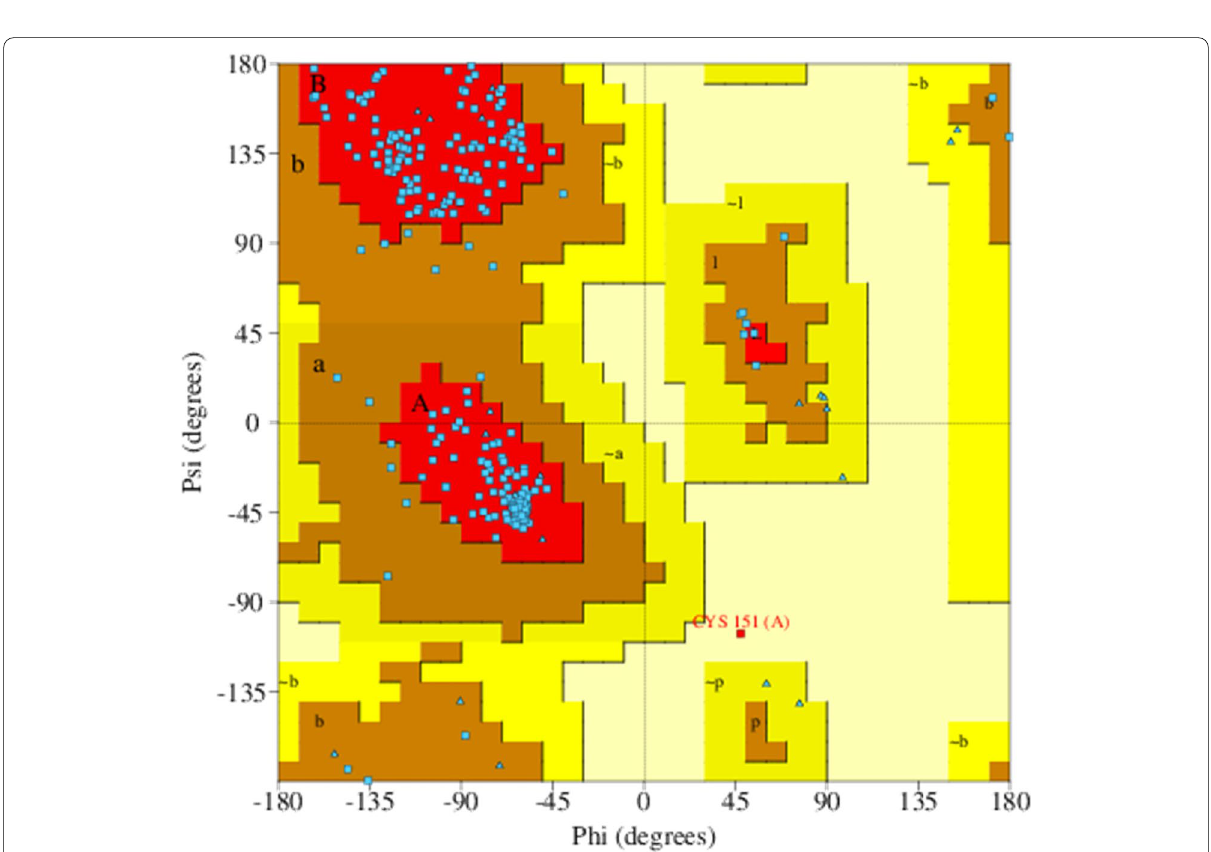
Fig. 6 Ramachandran plot of nitrilase-3 protein by